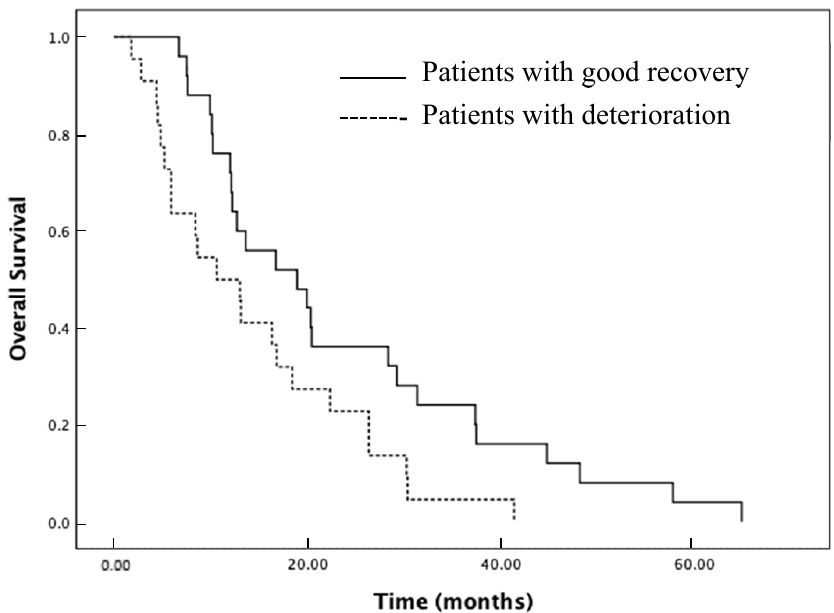
Figure 3. Kaplan–Meier estimates for mobility the deterioration (dotted line) and good recovery groups (solid line).